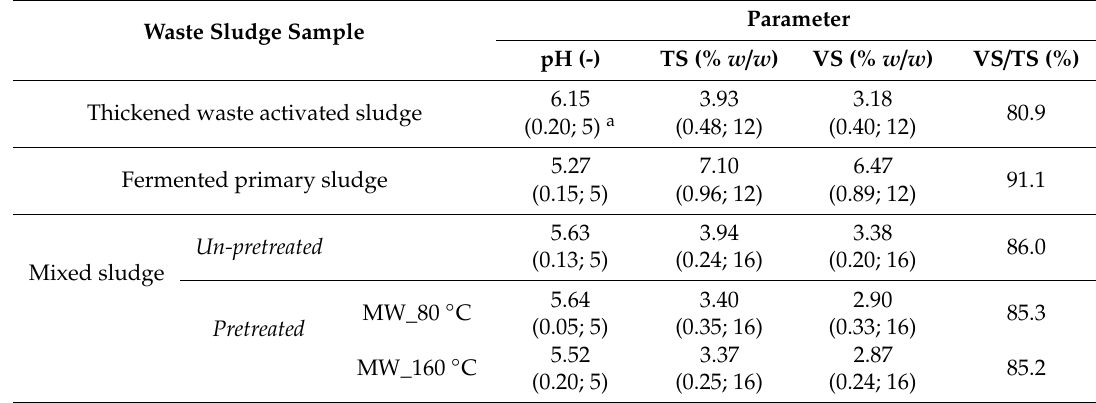
Table 2. Basic characteristics of waste sludge streams and mixed sludge samples.